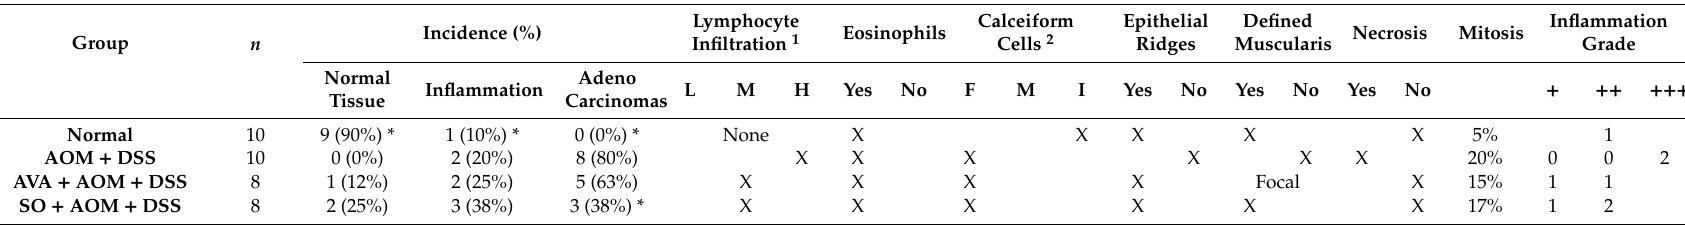
Lymphocyte Calceiform Epithelial Defined Inflammation Incidence (%) Eosinophils Necrosis Mitosis Cells 2 Ridges Muscularis Grade Infiltration 1 Normal Adeno Inflammation L M H Yes No F M I Yes No Yes No Yes No + ++ +++ Tissue Carcinomas